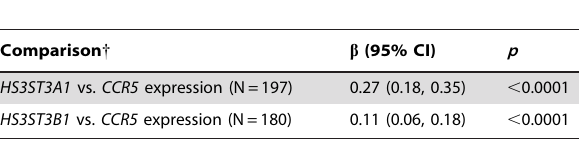
Table 2. Linear regression for the associations between gene expression